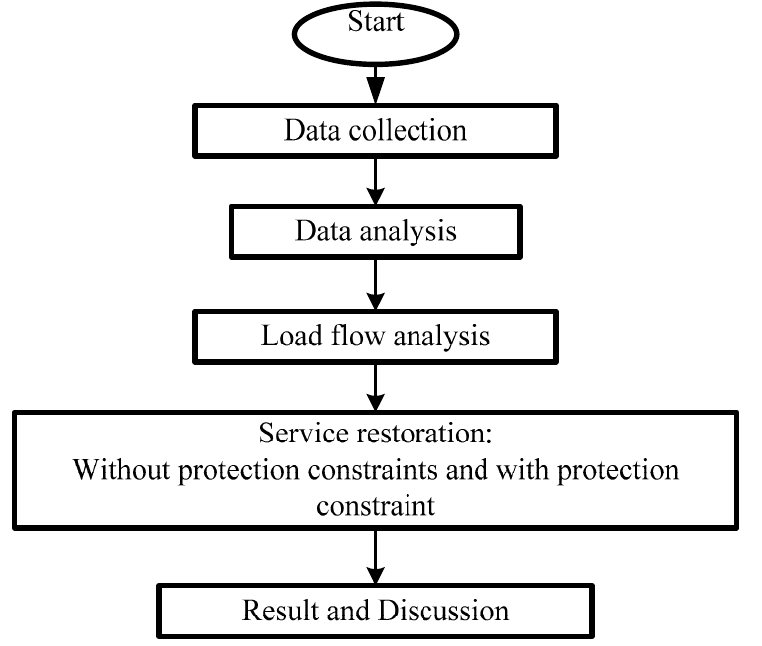
Figure 1. The overall methodology.